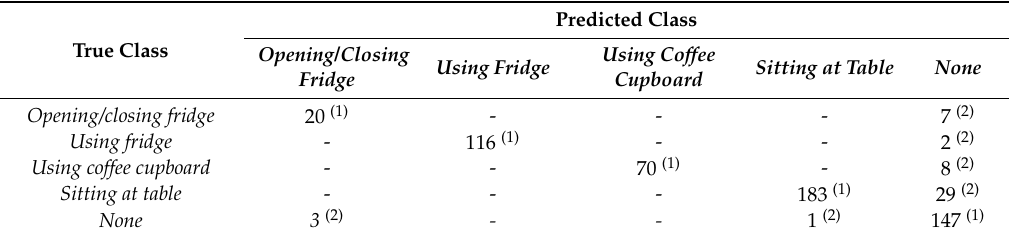
Table 11. The confusion matrix created from the activity